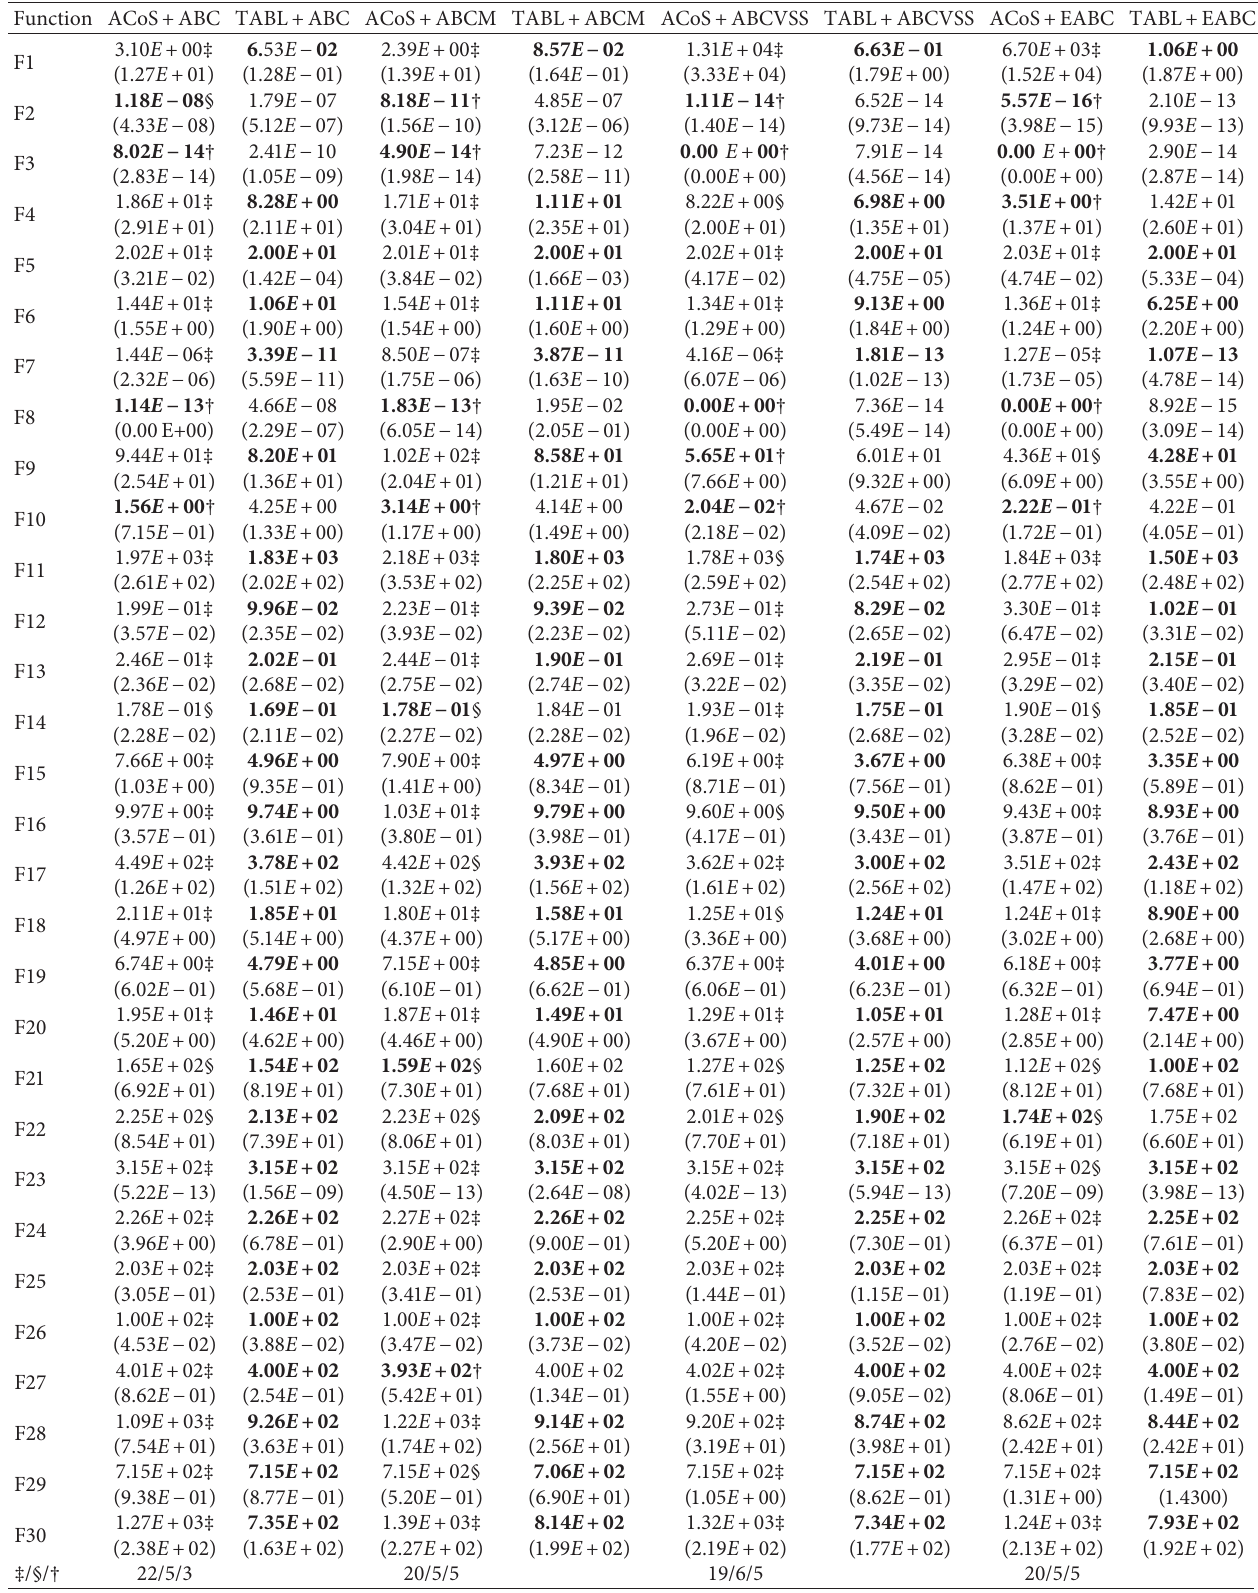
Table 5: The statistical results (mean (Std)) of ACoS+ABC vs. TABL +ABC, ACoS+ ABCM vs. TABL+ABCM, ACoS +ABCVSS vs. TABL+ABCVSS, and ACoS+EABC vs. TABL +EABC over 51 independent runs on the CEC2014 benchmarks with 30 D